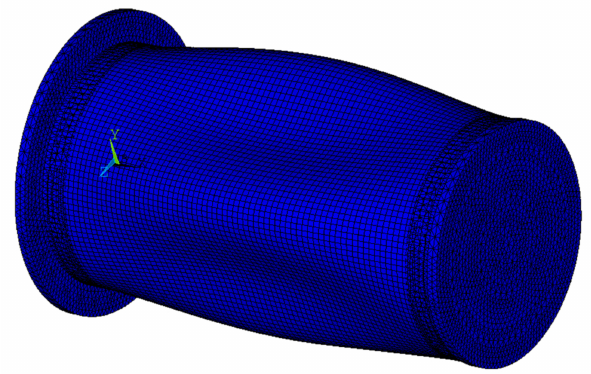
Figure 5. Buckling modes predicted by